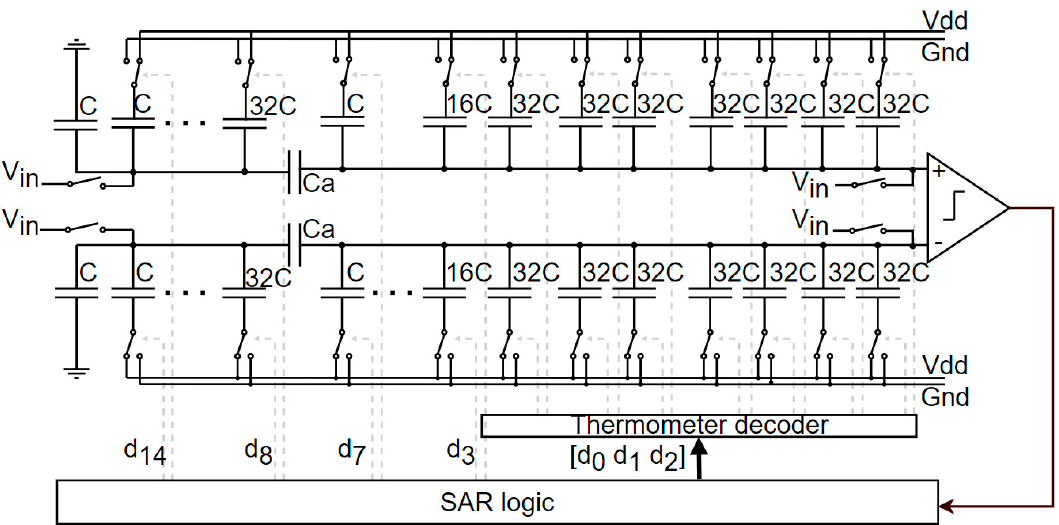
Figure 9. Diagram of our 15-bit ADC with 3-bit thermometer coding.